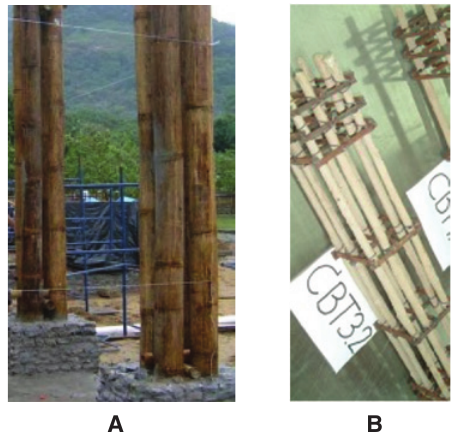
Figure 1: Bamboo as an engineering material in building construction.